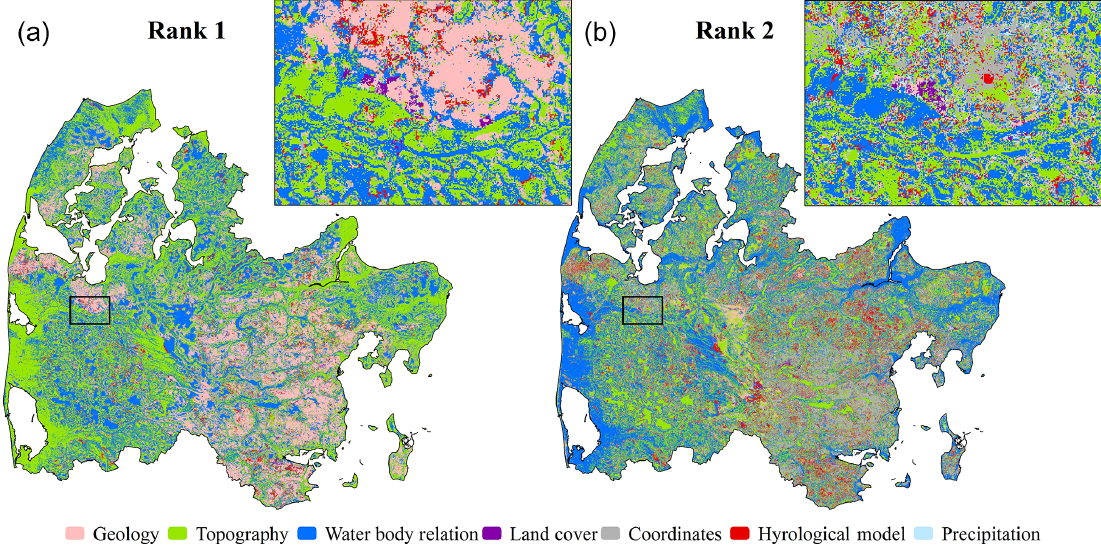
Figure 6. The results of the sensitivity analysis are shown for the most sensitive covariate group (Rank 1, a ) and the second-most important covariate group (Rank 2, b ). The city of Holstebro is chosen as the zoomed-in region for both maps.